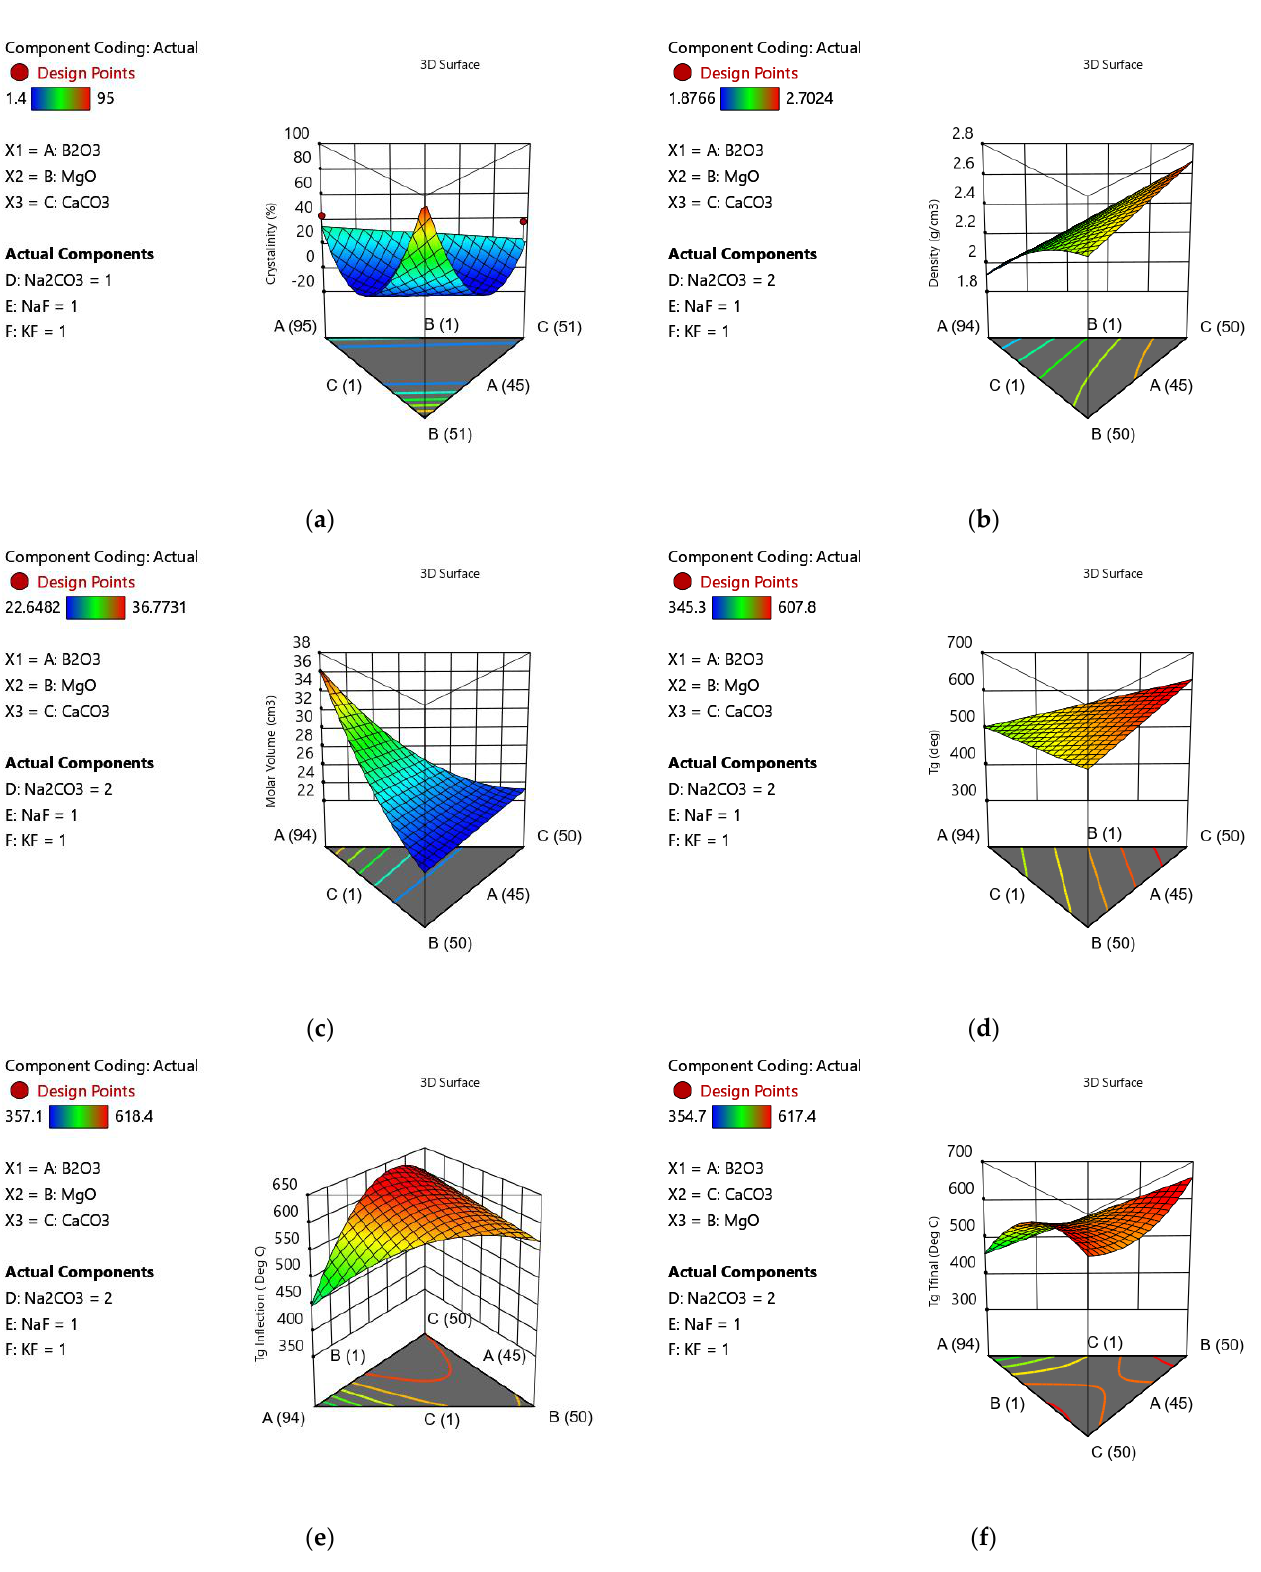
Figure 2. 3D surface plots demonstrating the nonlinear relationships between the glass composition and ( a ) crystallinity, ( b ) density, ( c ) molar volume, ( d ) Tg onset, ( e ) Tf inflection and ( f ) Tg final. To better visualise the impact of single glass components with opposing impacts as combination factors a graphical correlation table is presented in Figure 2. For example, it can be visualised that the impact of KF additions imparts a positive linear effect, along